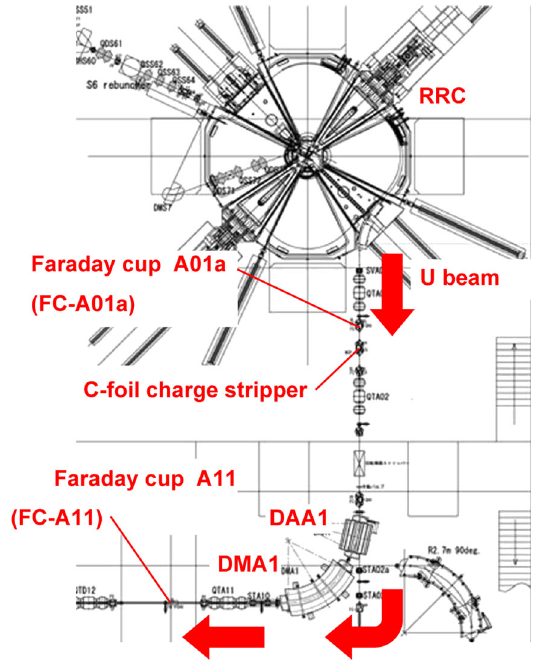
FIG. 3. Schematic view of the beam line around the C-foil charge stripper. The beam intensity upstream of the C-foil charge stripper was measured using a Faraday cup (FC-A01a). Stripped beams were analyzed using a pair of dipole magnets DAA1 and DMA1. The beam intensity downstream of DAA1 and DMA1 was measured using a Faraday cup